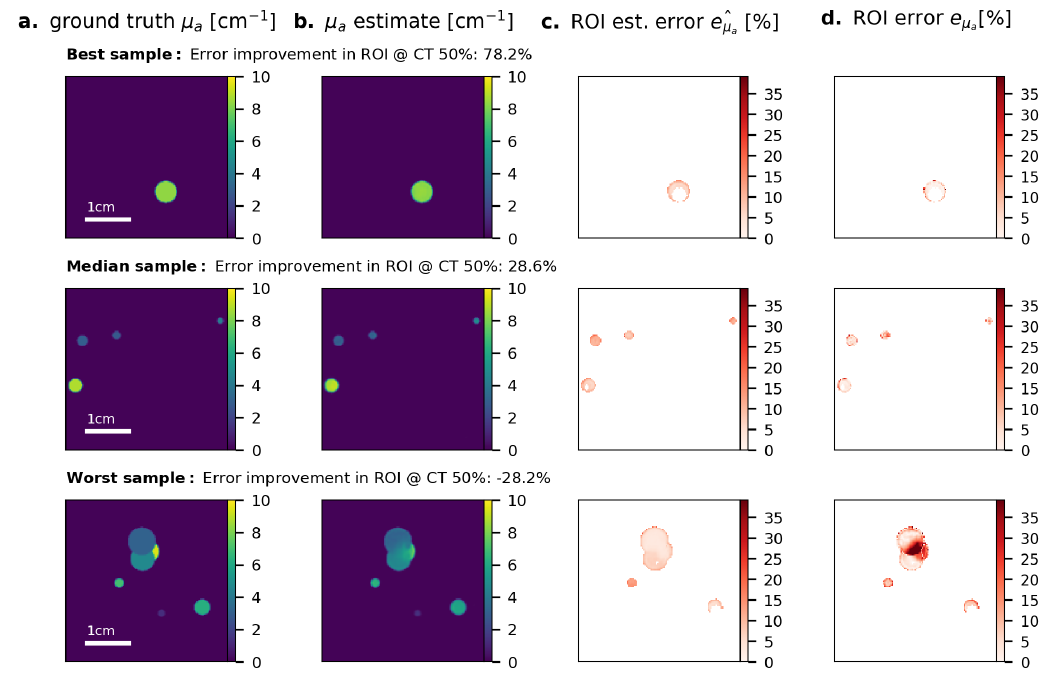
Figure 6. Visualization of the changes in the distribution of the absorption quantification error e µ when applying different confidence thresholds CT = { 100%, 50%, 10% } . The plot shows results for all five conducted experiments. The white line denotes the median, and the black box corresponds to the interquartile range. Outliers of e µ with a value greater than 100% have been omitted from this plot. a